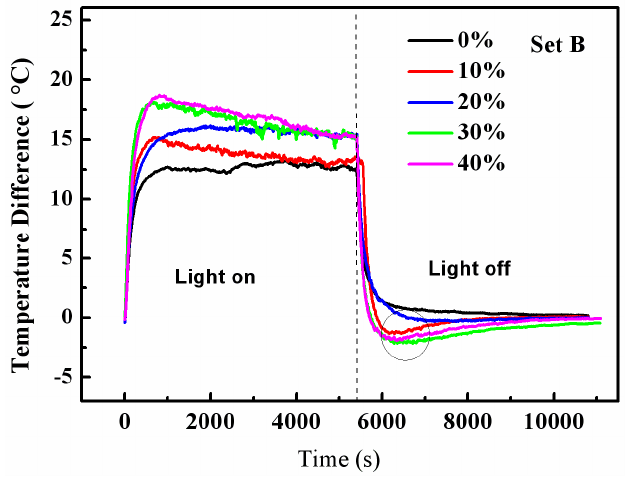
Figure 8. Variations of the temperature differences with time for the five test rooms composed of the top boards containing 0, 4, 8, 12 and 16 wt % of RT28, respectively (Set B). top boards containing 0, 4, 8, 12 and 16 wt % of RT28, respectively (Set